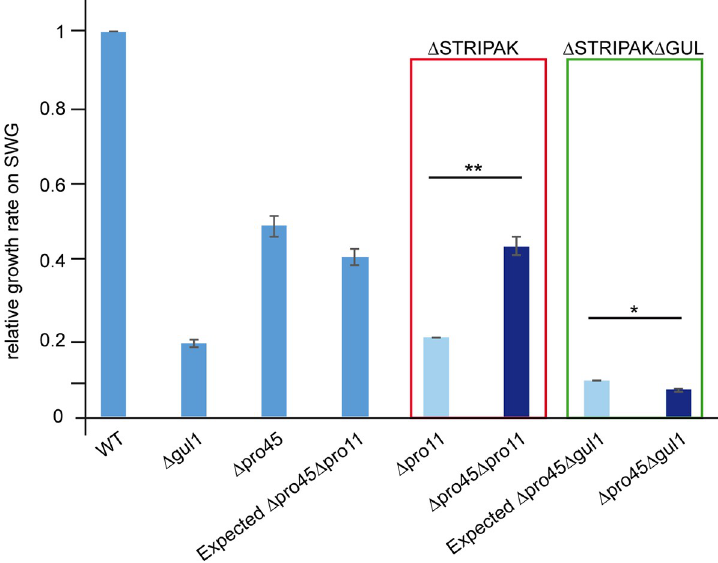
Fig 5. Analysis of the genetic interaction between gul1 and the slmap homologue pro45 . Genetic interaction was evaluated by comparing the daily vegetative growth rates of the indicated strains. The evaluation is based on the phenotype of the double mutant Δ gul1/ Δ pro45 compared to the single mutants. The double mutant Δ pro45/ Δ pro11 served as a control. Dark blue bars indicate experimentally generated values for single and double mutants, while light blue bars represent expected values for the double mutants based on multiplication of the values of the single mutants. The value of the wild type (wt) was set to 1 and all other values are given in relation to the wt. Absolute and relative values can be found in S2 Table. Error bars indicate standard deviations. Significant differences were evaluated by paired one-tailed Student´s t- test and are shown by lines � P � 0.05; �� P � 0.01. ( n = 9 see Strains and growth conditions for